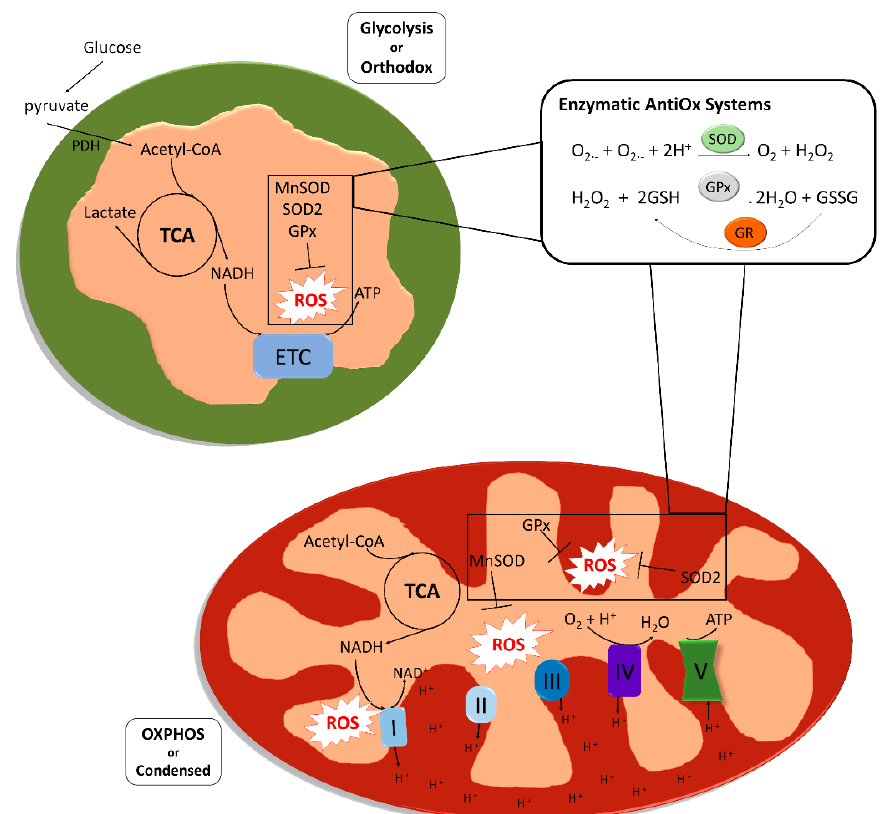
Figure 1. Structure, metabolic activity and reactive oxygen species (ROS) scavenging system in mitochondria. Mitochondria present in glycolytic cells with low oxidative phosphorylation (OXPHOS) rates are defined as “orthodox mitochondria” (colored as green), and are characterized by an ovoid form, large matrix volume, small intracristal volume and lamellar cristae. Mitochondria colored as red, the so called “condensed mitochondria”, are formed to provide cells with adenosine triphosphate (ATP) generated by OXPHOS. Condensed mitochondria are characterized by relatively small matrix volume and an expanded intracristae space with cristae shaped as a crescent. Both orthodox and condensed mitochondria share two enzymatic systems to counteract ROS that are produced in both glycolytic and OXPHOS metabolism. The first antioxidant reaction consists of the reduction of two superoxide anions to hydrogen peroxide catalyzed by a superoxide dismutase (SOD2 or MnSOD). The glutathione peroxidase catalyzes the reduction of the hydrogen peroxide to water oxidizing a glutathione molecule. Glutathione reductase catalyzes the reduction of the oxidized glutathione molecule, thus renewing reduced glutathione reservoir (ATP, adenosine triphosphate; ETC, electronic transport chain; GPx, glutathione peroxidase; GR, glutathione reductase; NAD, nicotinamide adenine dinucleotide; OXPHOS, oxidative phosphorylation; PDH, pyruvate dehydrogenase; ROS, reactive oxygen species; SOD, superoxide dismutase; TCA, tricarboxylic